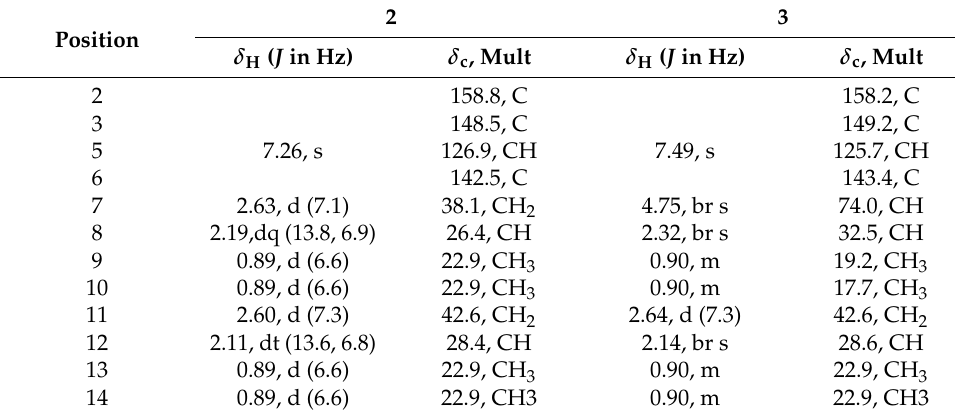
Table 1. 1H NMR and 13C NMR spectra of compounds 2 and 3 in